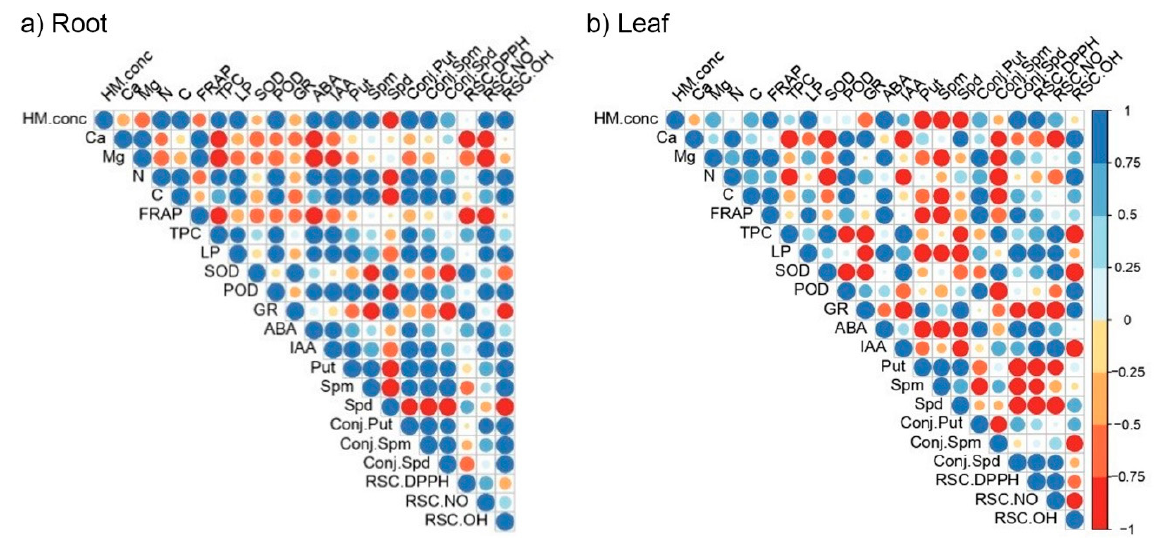
Figure 6. Pearson’s correlation matrix of all analyzed parameters for roots ( a ) and leaves ( b ) exposed to increased levels of Ni and Cd. The following abbreviations examined the parameters. TPC: total phenolic content; FRAP: ferric reducing antioxidant power; LP: lipid peroxidation; SPD: spermi- dine; SPM: spermine; PUT: putrescine; SOD: superoxide dismutase; POD: guaiacol peroxidase; GR: glutathione reductase; ABA: abscisic acid; IAA: indole-3-acetic acid; and DPPH: 2,2-Diphenyl-1- picrylhydrazyl